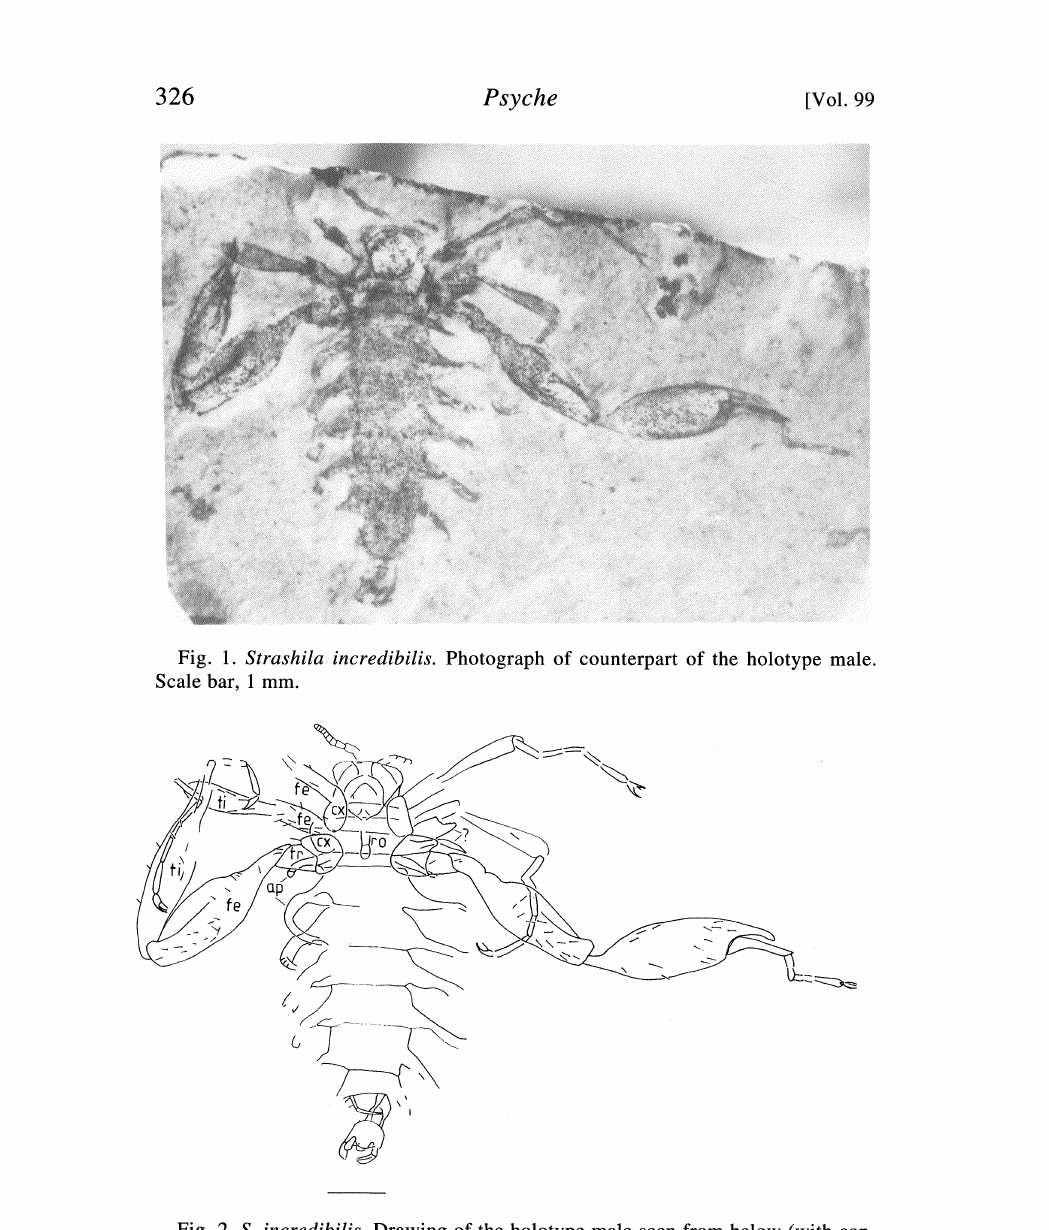
Fig. 2. S. incredibilis. Drawing of the holotype male seen from below (with con- tours of structures supposed lying more dorsal being interrupted when overlaid from below with structures of more ventral position). Scale bar, mm. Abbrevia- tions: ap lateral abdominal appendage, cx coxa, fe femur, ti tibia, tr trochanter, ? structure of obscure